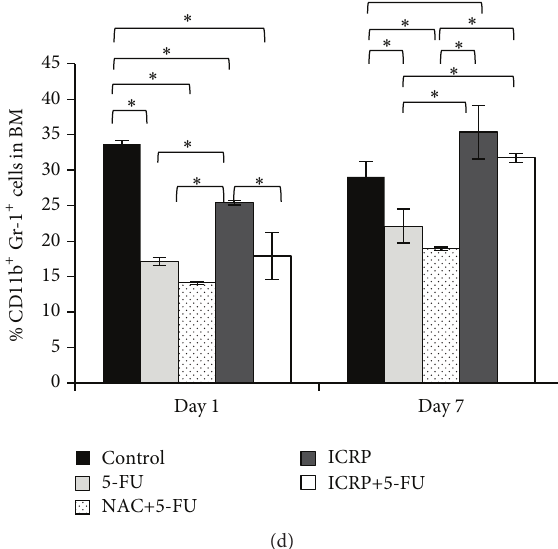
Figure 3: Flow cytometry analysis: BM cells from both femora and tibia were obtained on day 7 from treated mice. Subsequently, BM cells were analyzed for expression of the cell surface markers by flow cytometry. (a) Representative result of flow cytometry analysis for CD45 + BM cells. (b) Statistics from CD45 + BM cells. (c) Representative result of flow cytometry analysis for CD11b + Gr-1 + BM cells. (d) Statistics from CD11b + Gr-1 + BM ∗ (𝑃 < 0.05 ) ( 𝑛 = 3 ).